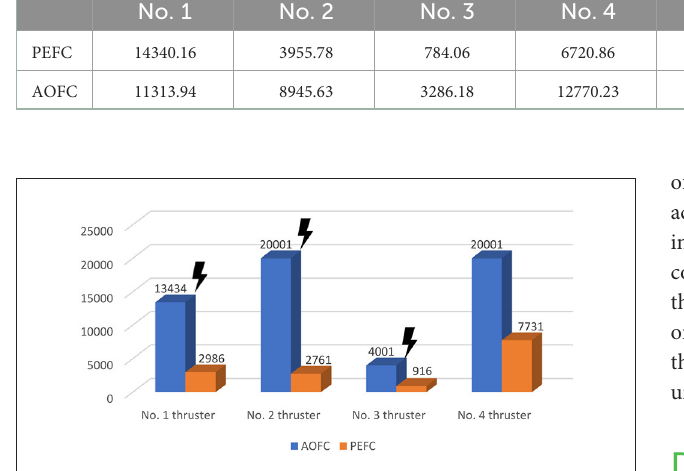
FIGURE11 Time between thruster maneuvers.